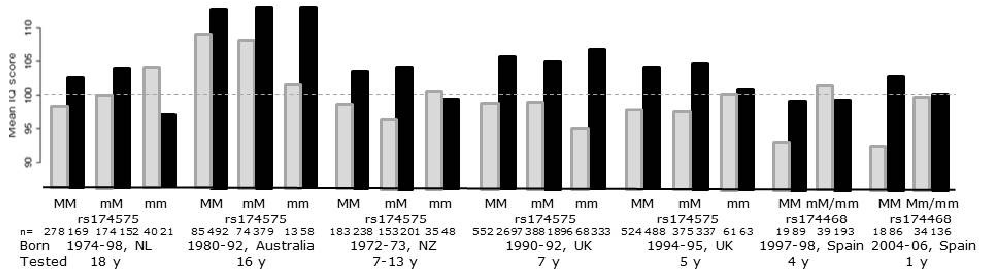
Figure 1. Results from studies examining the potential modifying effect of single nucleotide polymorphisms in the fatty acid desaturase gene cluster on the effect of breastfeeding on IQ-like neurodevelopmental outcomes in children. The figure is based on data from [46,65–68] and gives the average IQ in the SNP×feeding groups (breast ‐ fed in black and formula ‐ fed in light gray). The grey stippled line is the reference line for mean normal IQ.